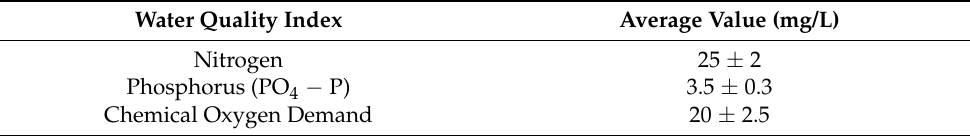
Table 1. Characteristics of synthetic wastewater.